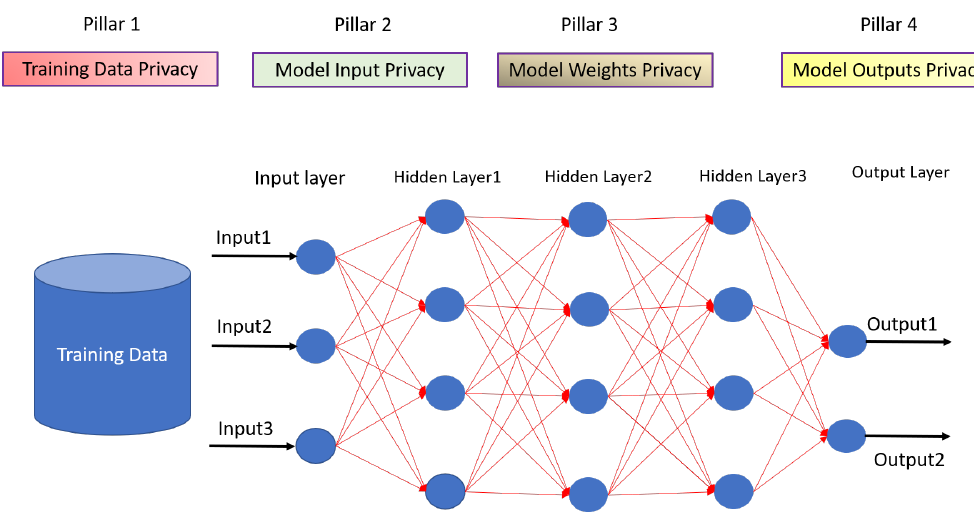
Figure 1. Four Pillars of Privacy-Preserving Machine